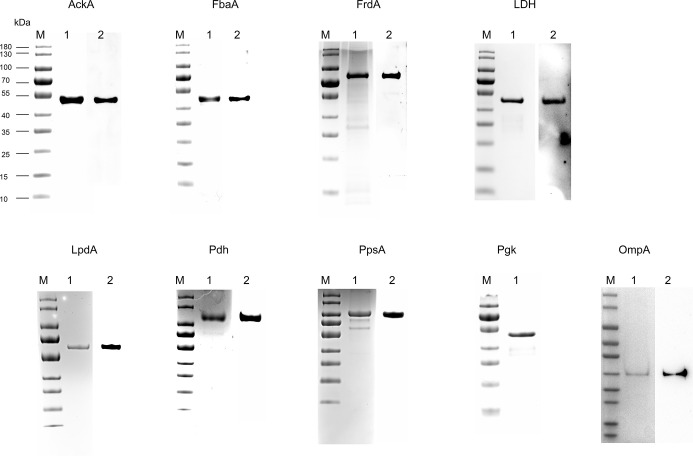
Expression of recombinant proteins and preparation of corresponding antibodies. His-tag recombinant protein AckA, FbaA, FrdA, LDH, LpdA, Pdh, PpsA, Pgk, and OmpA, were analyzed by SDS-PAGE and stained with Coomassie G-250 (lane 1 in each panel). The recombinant proteins (except Pgk) were hybridized to their specific polyclonal antibodies and HRP-conjugated anti-rabbit IgG (lane 2 in each panel).